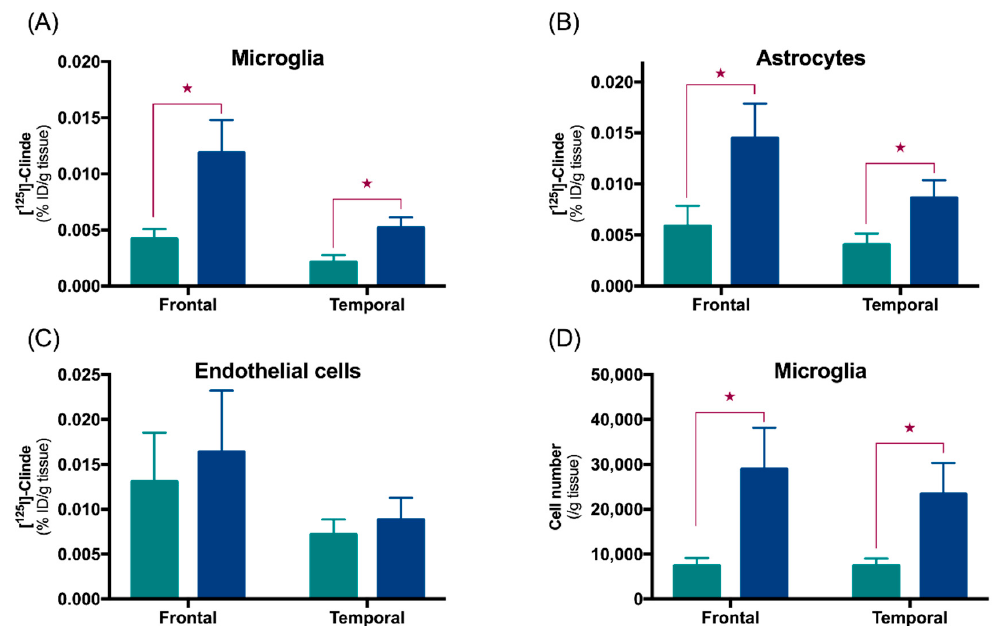
Figure 5. TSPO is increased in astrocytes and microglial cells in the frontal and temporal cortex of Alzheimer’s disease subjects. ( A – C ) The [ 125 I]CLINDE binding is used to assess TSPO density in the frontal and the temporal cortex of control (green) and AD (blue) samples. Radioactivity was determined in microglia (CD45 + cells), astrocytes (GLT1 + cells) and endothelial cells (CD31 + cells) and expressed as % injected dose (ID) /g of tissue. ( D ) The number of microglial cells sorted. ★ : p < 0.05. Adapted from References [122,129].